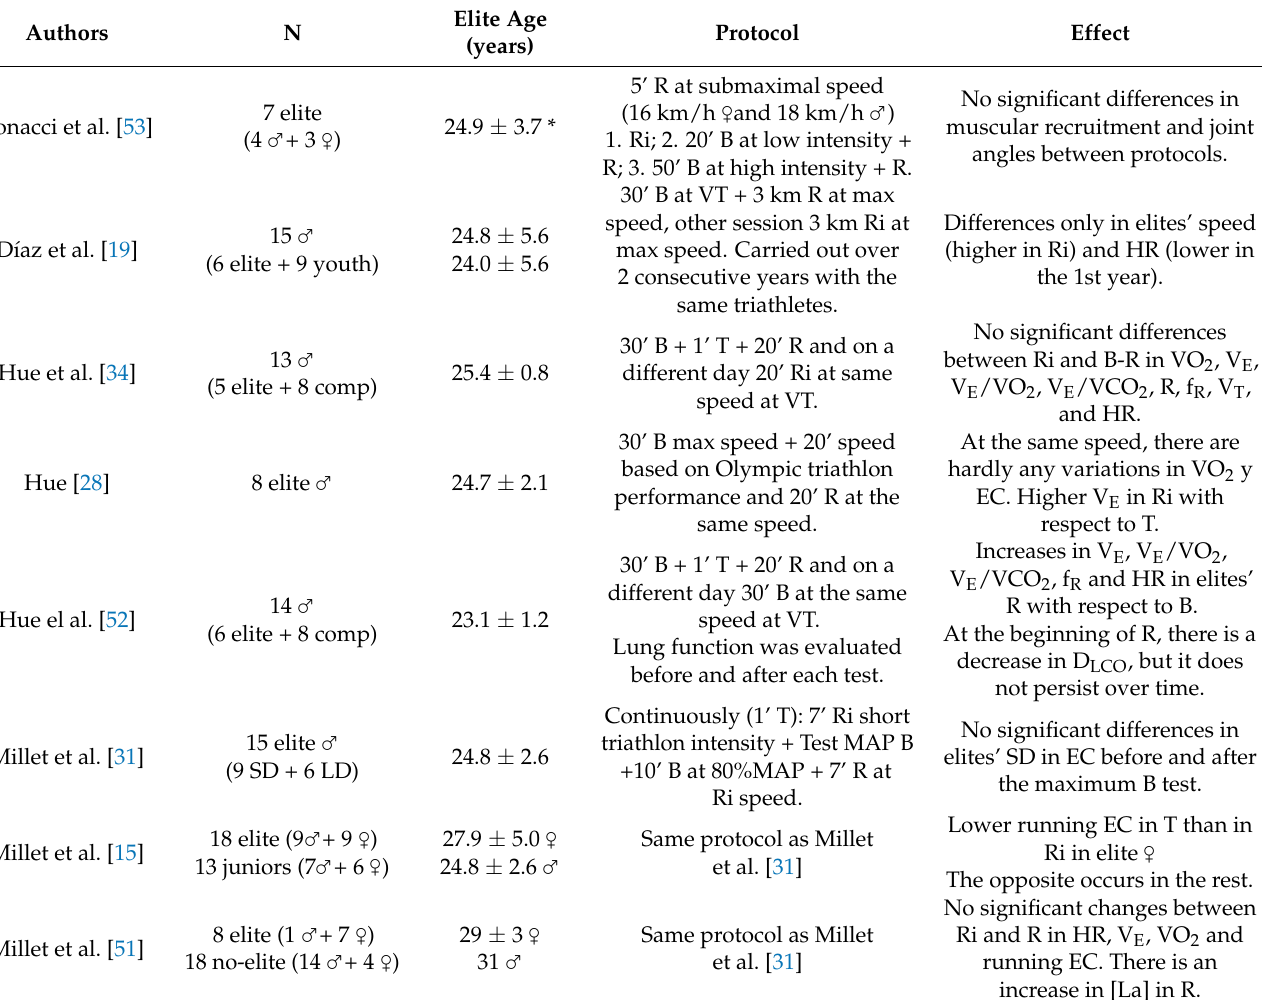
Table 9. Effect of cycling on the running performance of elite